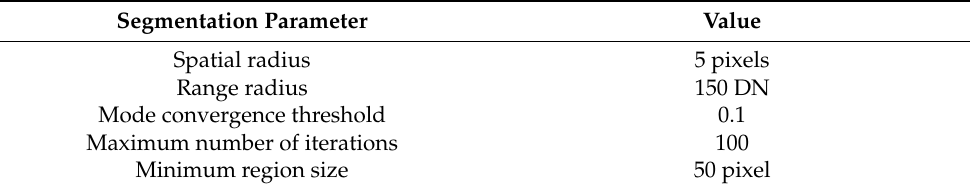
Table 3. Parameters used during image segmentation.